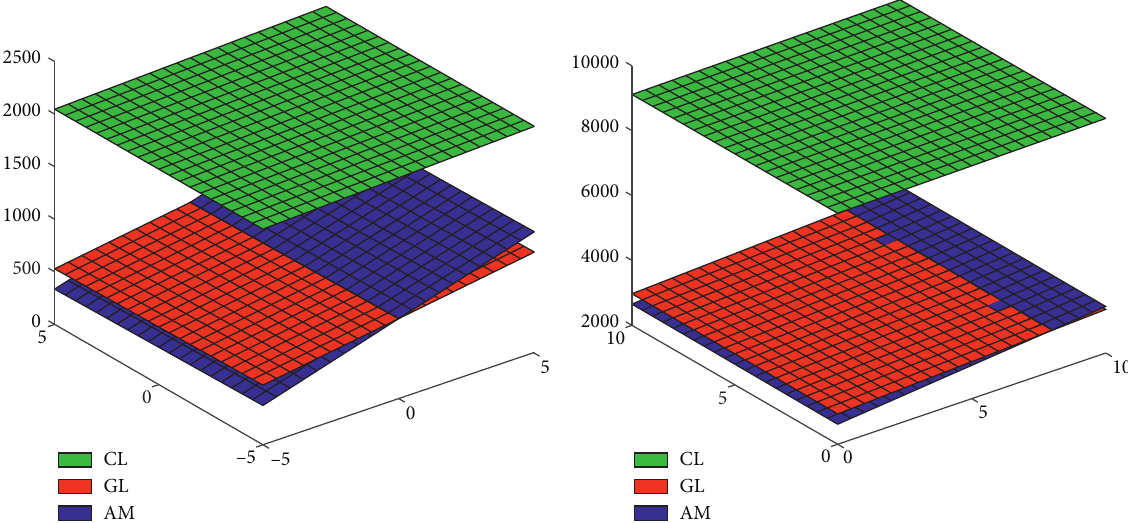
l l R (− 1/2 ) and χ (− 1/2 ) . (a) 3D graphs of the Randi´c index. (b) 3D graphs of the sum- m , GL m , and AM m using